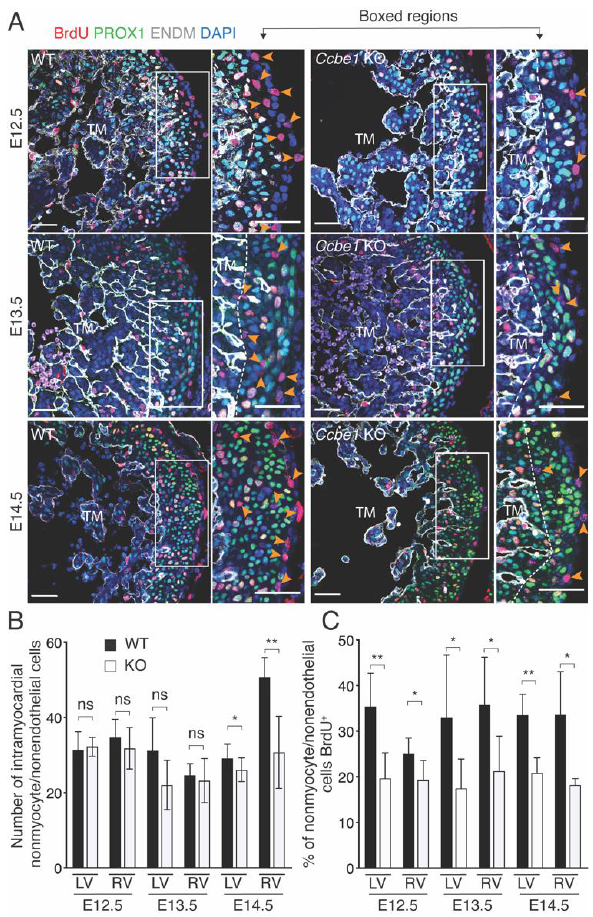
Figure 6. Nonmyocyte/nonendothelial cells are reduced and show less proliferation rate in Ccbe1 KO hearts. ( A ) Tissue sections through E12.5, E13.5 and E14.5 wild-type and Ccbe1 mutant hearts treated with BrdU and immunostained for BrdU, PROX1, and ENDM to reveal proliferating and nonproliferating nonmyocyte/nonendothelial cells. Orange arrowheads indicate proliferating (BrdU + ) nonmyocyte/nonendothelial cells. Images are representative of the following number of replicates: wild-type, n = 5; mutant, n = 5 at E12.5; wild-type, n = 5; mutant, n = 6 at E13.5; wild-type, n = 5; mutant, n = 5 at E14.5. ( B ) Quantification showed reduced percentage of nonmyocyte/nonendothelial cells in right and left ventricles of Ccbe1 mutant hearts at E14.5. ( C ) Quantification showed that nonmyocyte/nonendothelial cell proliferation in compact myocardium is reduced in right and left ventricles of Ccbe1 mutant hearts at E12.5, E13.5 and E14.5. Dashed lines in ( A ) delimitate compact from trabecular myocardium. ns, nonsignificant; * p < 0.05; ** p < 0.01. Differences were considered statistically significant when p < 0.05. Error bars represent SDs. Scale bars = 100 µ m. TM, trabecular